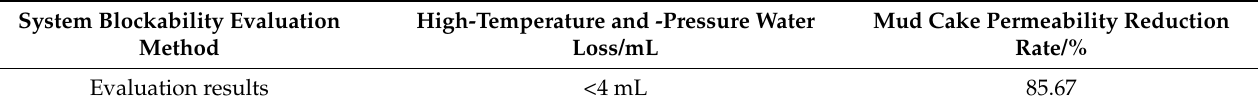
Table 4. Field evaluation of plugging performance of water-based drilling fluid system.